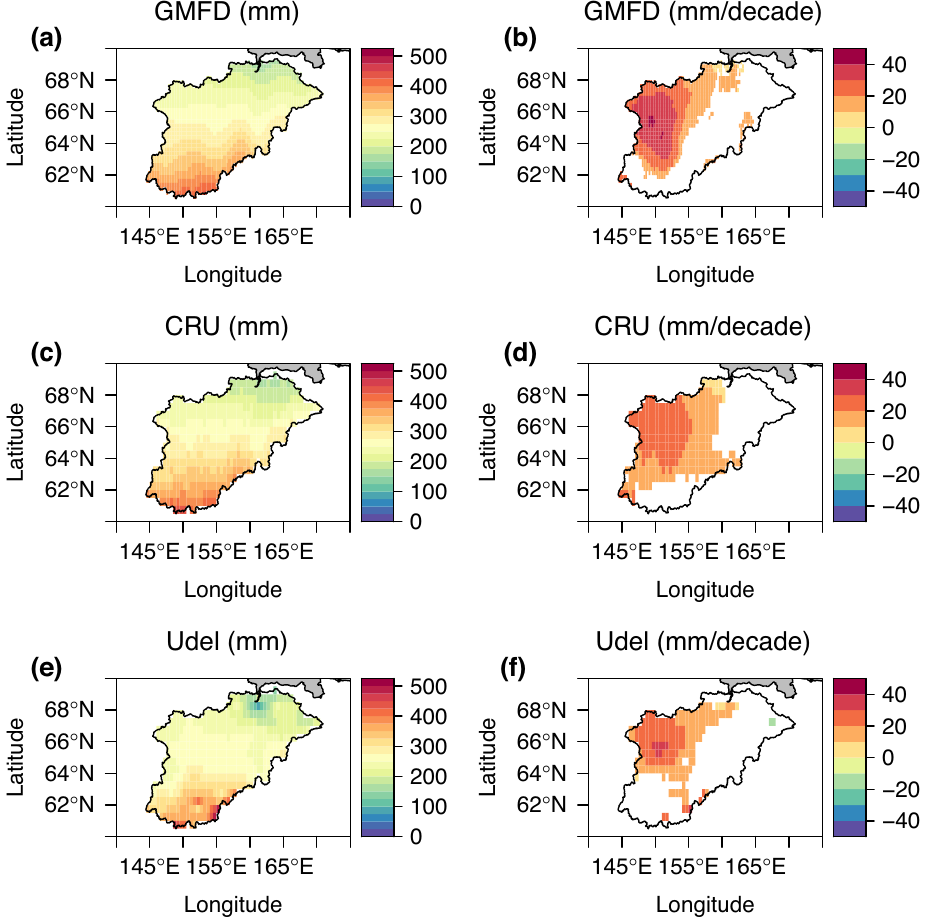
Figure 4. Climatology and trend in annual mean precipitation by three different forcing datasets from 1979 to 2012. Climatology derived from ( a ) GMFD, ( c ) Climatic Research Unit (CRU), and ( e ) University of Delaware (Udel) and linear trend with statistical significance ( p < 0.05) derived from ( b ) GMFD; ( d ) CRU, and ( f )